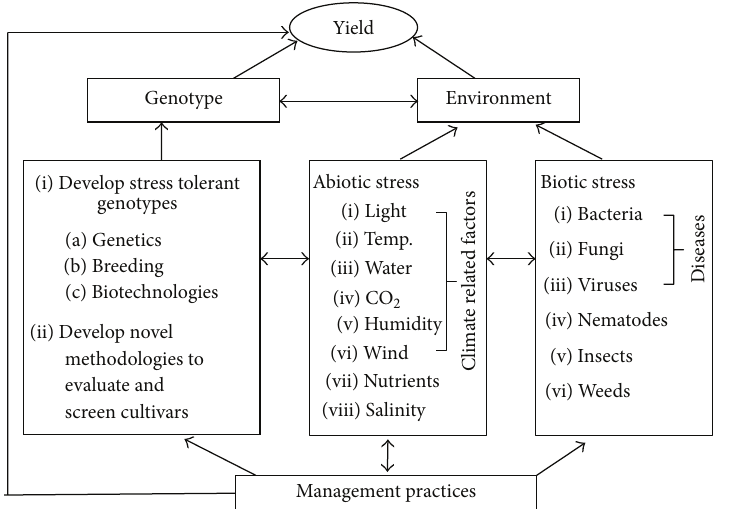
Figure 2: A flow chart to demonstrate major factors (genotype, environment, and management practices) influencing sugarcane yield as well as their